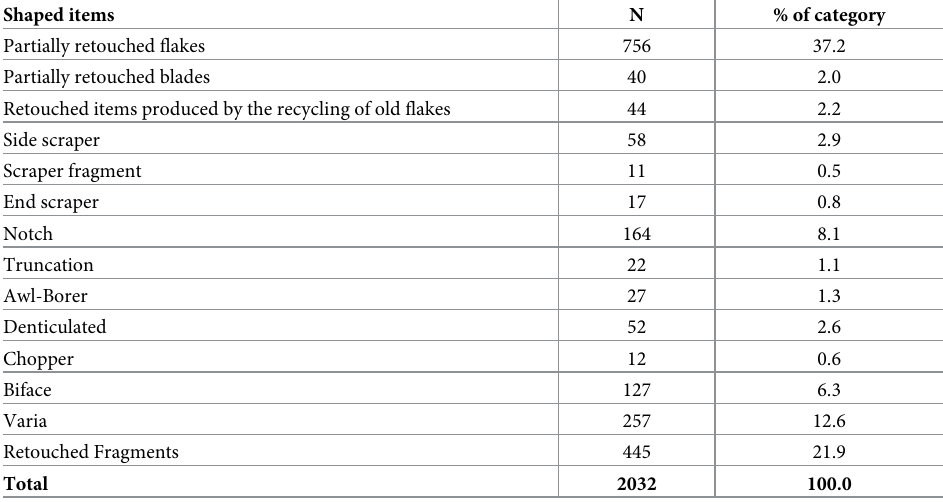
Table 9. Shaped items typology and frequencies. Shaped items